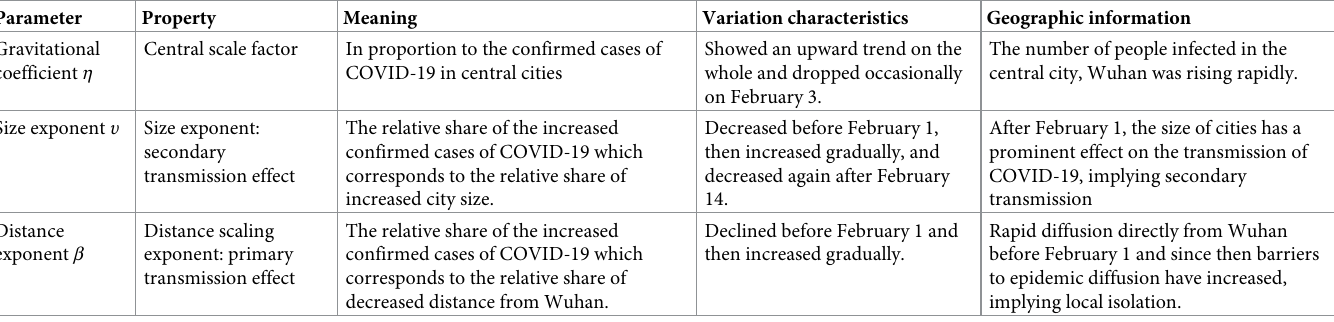
Table 3. The meanings, variation characteristics and geographical phenomena of parameters of gravity model of COVID-19 spread in Hubei Province. Parameter Property Meaning Variation characteristics Geographic information